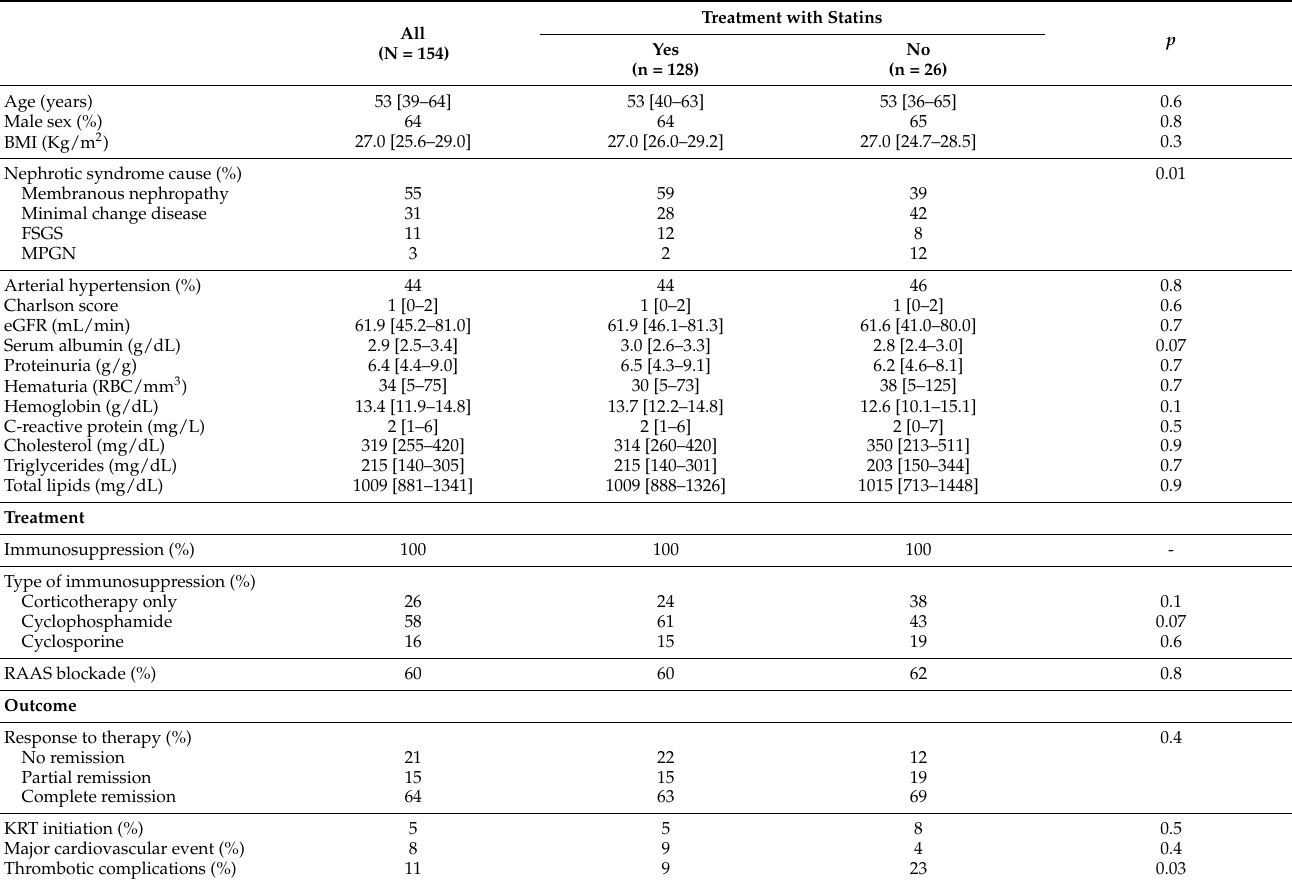
Table 1. Patients’ characteristics at baseline and according to statin